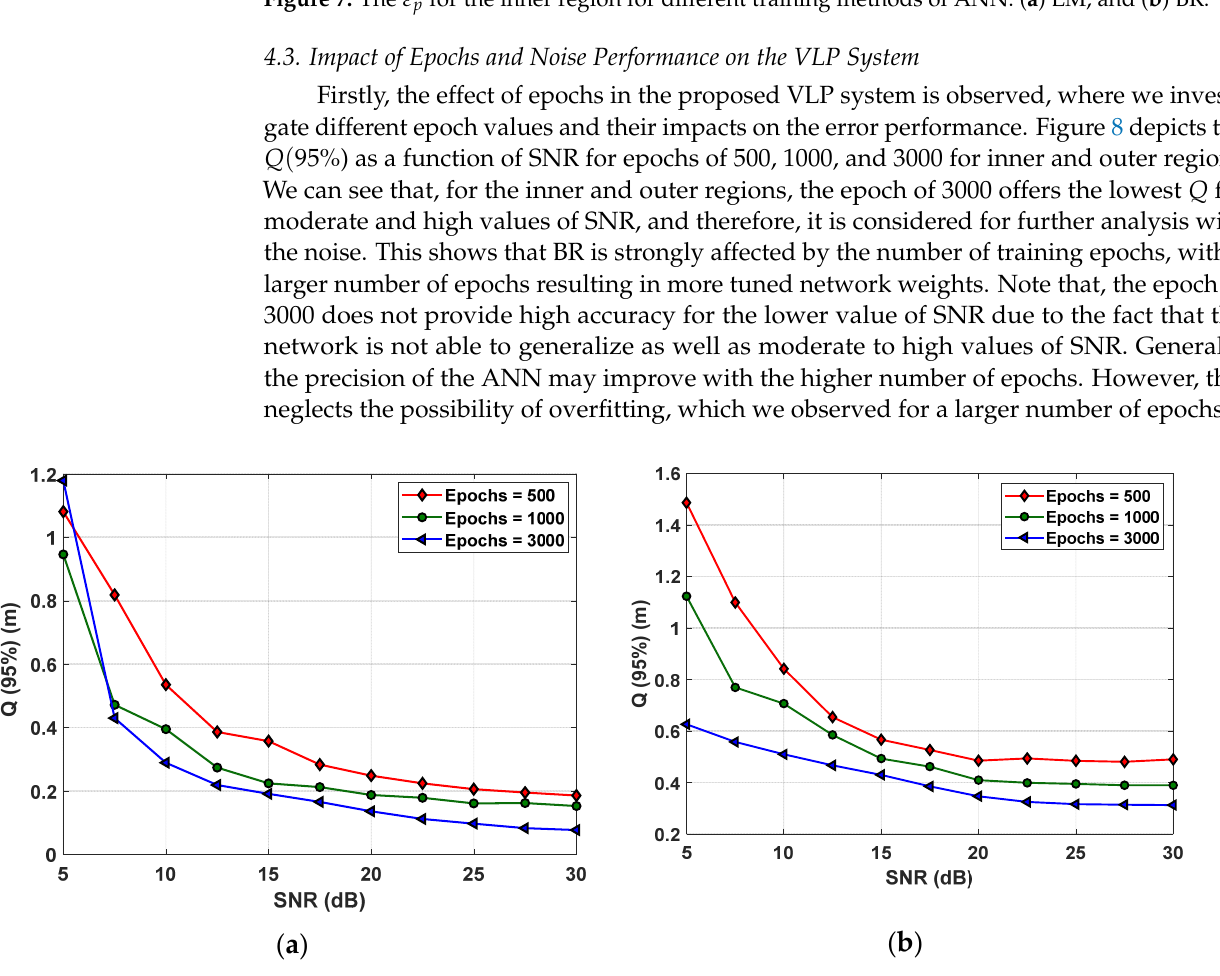
Figure 8. The measured 95% quantile function for a various number of epochs for BR in the: ( a ) inner, and ( b ) outer regions.